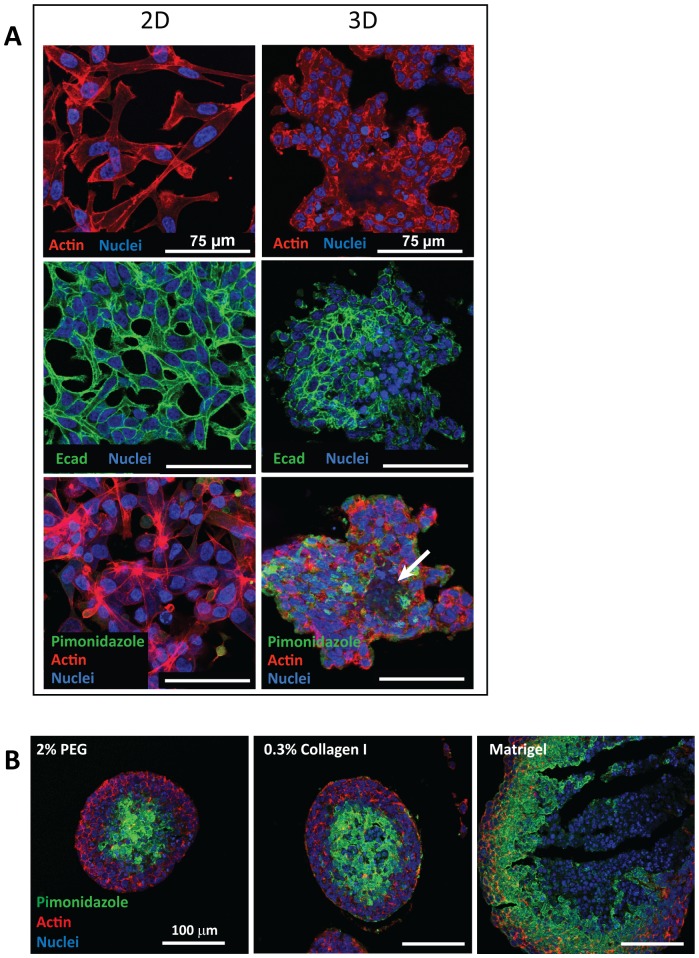
Immunofluorescent staining of LNCaP cells cultured in normal growth media from 2D and 3D cultures.(A) A comparison of 2D cultures (day 6) and histology sections of 3D cultures (day 28) reveals differences in cell morphology and phenotype. Cytoskeletal organization (actin, red) of cells in 2D cultures reveals a spread out and elongated cell morphology (top panel). The cell and nucleus (blue) size of 2D cultures is larger than the 3D cultures. In 3D cultures, cells adopt a cobblestone morphology and compact cell arrangement. They also form extensive cell-cell contact within the colony. Epithelial marker, E-cadherin (Ecad, green) is localized in the cell membrane and in cell-cell contacts for both cultures (middle panel). Hypoxia staining with Pimonidazole (green) indicates that there are less hypoxic cells in 2D cultures relative to 3D cultures (bottom panel). Hypoxia is detected within the LNCaP colony in the presence of an apoptotic core (arrow). (B) Pimonidazole stainings performed on LNCaP cells cultured in the PEG hydrogels, Collagen I and Matrigel™ for 24 days show presence of hypoxia in all the matrices. CLSM images were taken at 40× magnification and 1.25 NA. Scale bars: (A) 75 µm and (B) 100 µm.